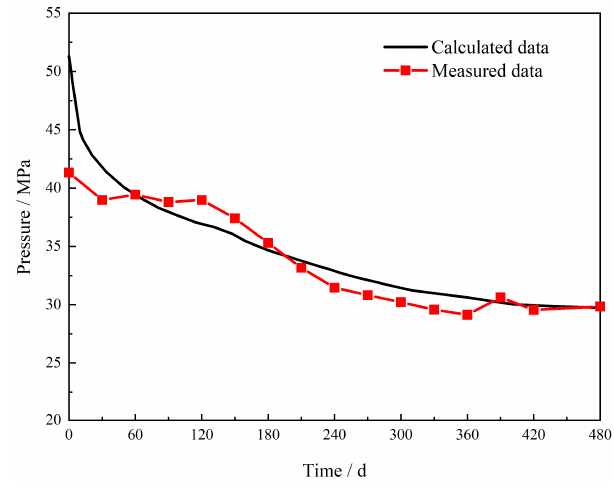
Figure 6. Comparison of measured and calculated pressure data.